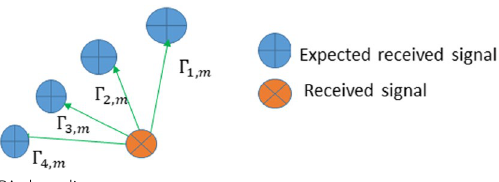
Fig. 5 Joint HIC-Log MPA